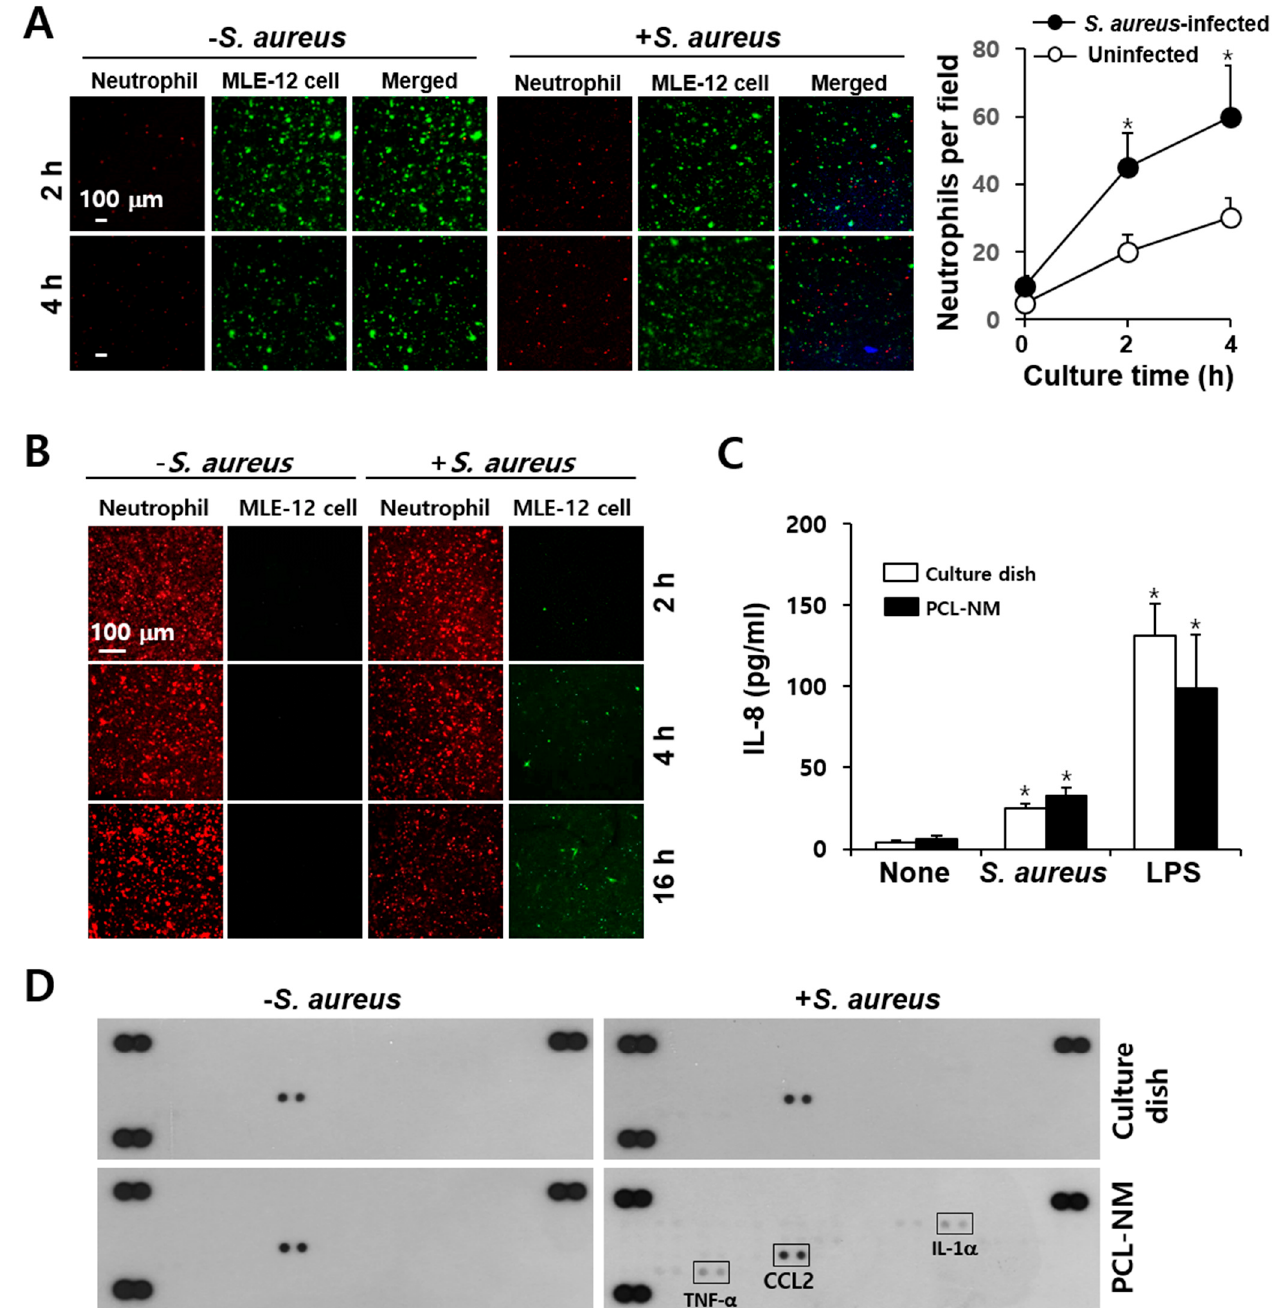
Figure 7. Migration of neutrophils to S. aureus -infected epithelial cells in the PCL-NM-based two-layer culture system . ( A ) PKH67-labeled MLE-12 cells (1 × 10 5 ) were incubated with or without DAPI-stained S. aureus (1 × 10 7 CFU) for 12 h in the lower PCL-NM and washed with culture media. PKH26-labeled peritoneal neutrophils (1 × 10 5 ) were seeded on the upper PCL-NM and cultured for the indicated times with untreated and bacteria-infected MLE-12 in the lower PCL-NM. Red-fluorescent spots were detected in the lower PCL-NM containing PKH67-labeled uninfected and S. aureus -infected MLE-12 cells (Epithelial cell) ( n = 3). The graphs depict the numbers of red-fluorescent spots detected in the lower PCL-NM. Data are presented as means ± SDs ( n = 3). Asterisks (*) denote significant differences compared to uninfected MLE-12 cells ( p < 0.05). ( B ) Green-fluorescent spots of MLE-12 cells (Epithelial cell) were detected on the upper PCL-NM containing PKH26-labeled neutrophils (Neutrophil) ( n = 3). ( C ) MLE-12 cells (1 × 10 5 ) were cultured with media alone (None), S. aureus (1 × 10 7 CFU) and LPS (1 µg/mL) for 12 h on a culture dish and in the PCL-NM. The secretion of IL-8 was measured by ELISA. Data are presented as means ± SDs ( n = 3). Asterisks (*) denote significant differences compared to None ( p < 0.05). ( D ) MLE-12 cells (1 × 10 5 ) were cultured with (+) or without ( − ) S. aureus (1 × 10 7 CFU) for 12 h on a culture dish and in the PCL-NM. Cytokines and chemokines secreted in the culture media were detected using cytokine and chemokine arrays ( n = 3).